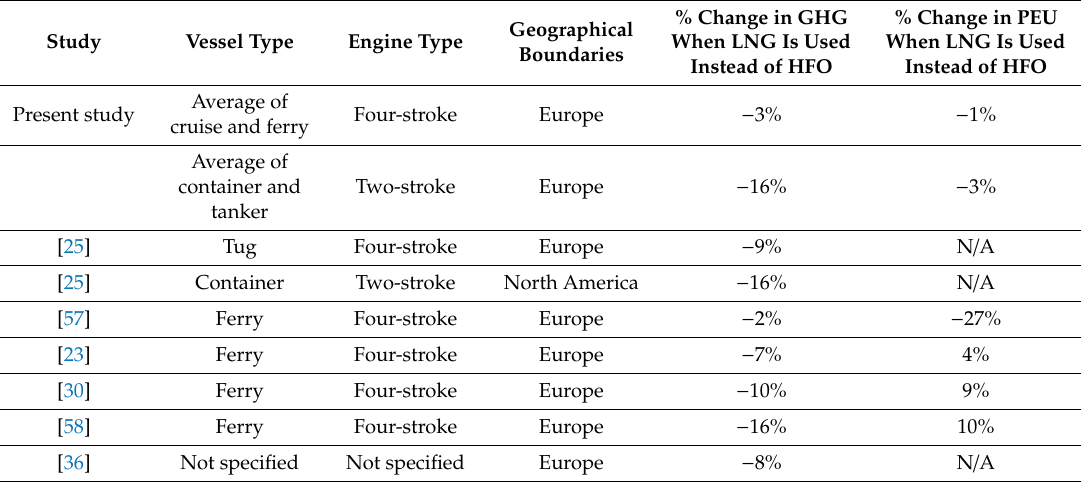
Table 9. Case studies used for